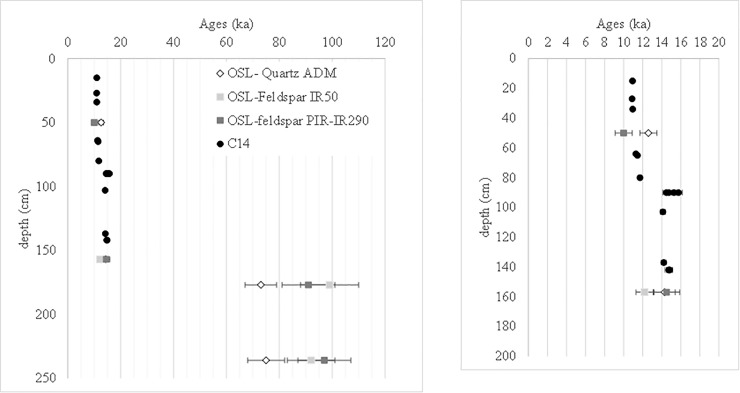
Ages in function of the relative stratigraphic location.The inset displays a zoom on the LSA sequence.